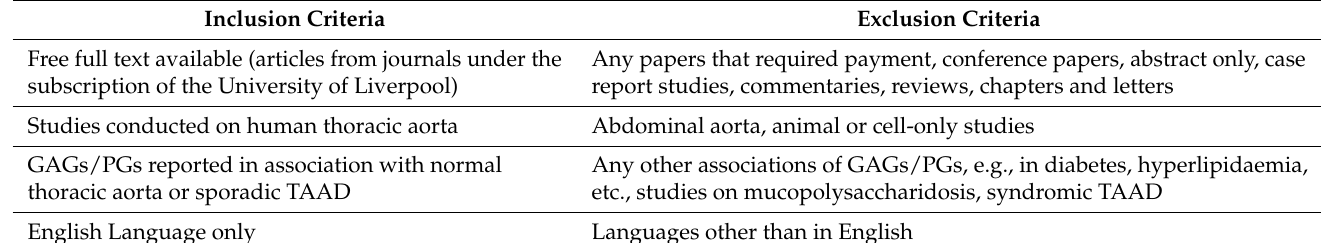
Table 1. Inclusion and exclusion criteria for healthy aorta and TAAD. The criteria were defined before conducting the search for article selection for both normal and TAAD